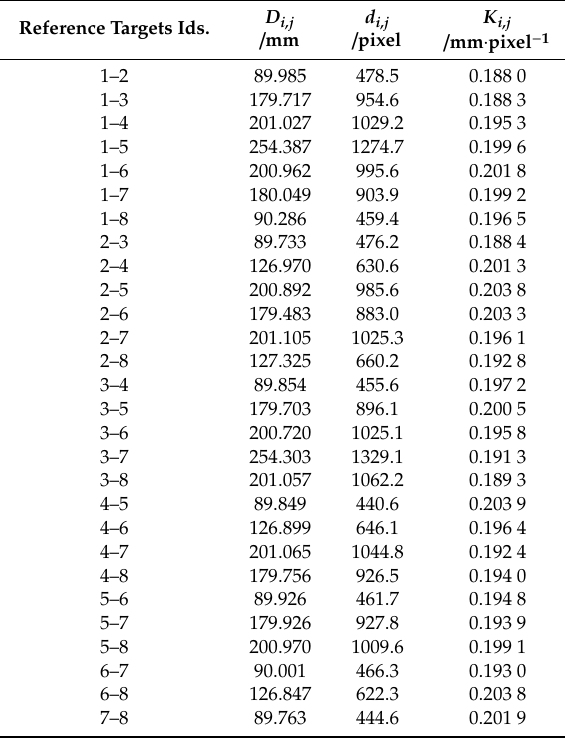
Table A1. Sample of calculated scale coe ffi cients related to referential A. Reference Targets Ids.